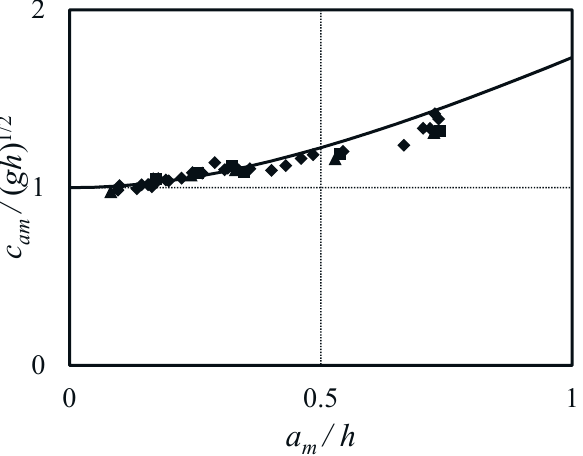
Figure 6. Waves generated by mesh-packed slides, mean relative wave crest celerity c am /( gh ) 1/2 versus mean relative wave amplitude a m / h for ( ▲ ) α = 30°, ( ■ ) α = 45°, ( ♦ ) α = 60°, ( ─ ) Equation